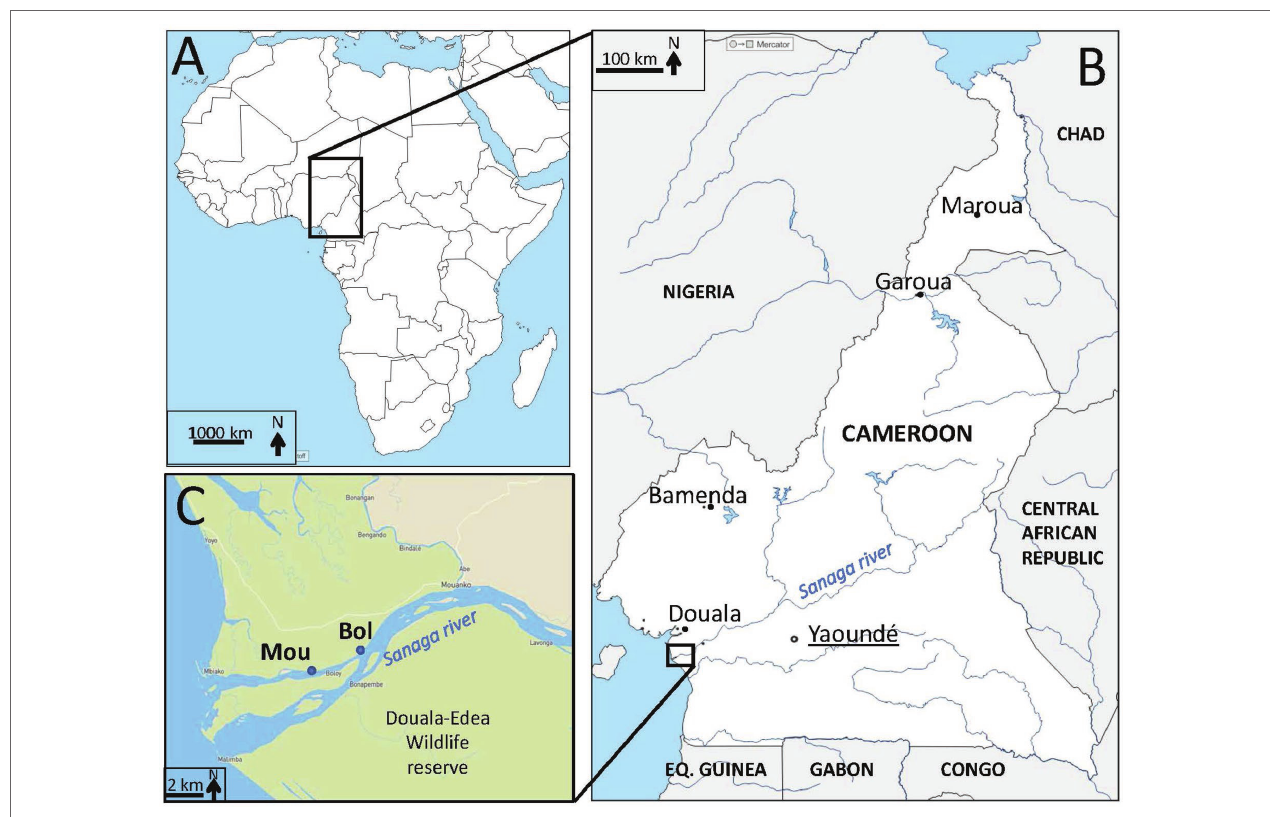
FIGURE 1 | Localization of sampling sites. (A) Map of Africa (d-maps.com) with Cameroon in the central region. (B) Map (d-maps.com) of Cameroon (white) with frontiers (black lines), neighboring countries (grey), capital (black circle, underlined) and main cities (black dots), main rivers and lakes (blue) including the Sanaga river. Eq. Guinea = Equatorial Guinea. (C) Zoom on the Sanaga river estuary with the location of study sampling sites (Bol, Mou) on the Sanaga river in the Douala- Edéa wildlife reserve (light